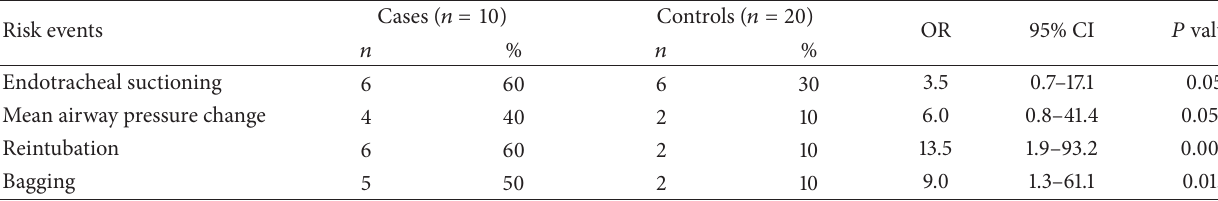
Table 2: Relationship of risk events to